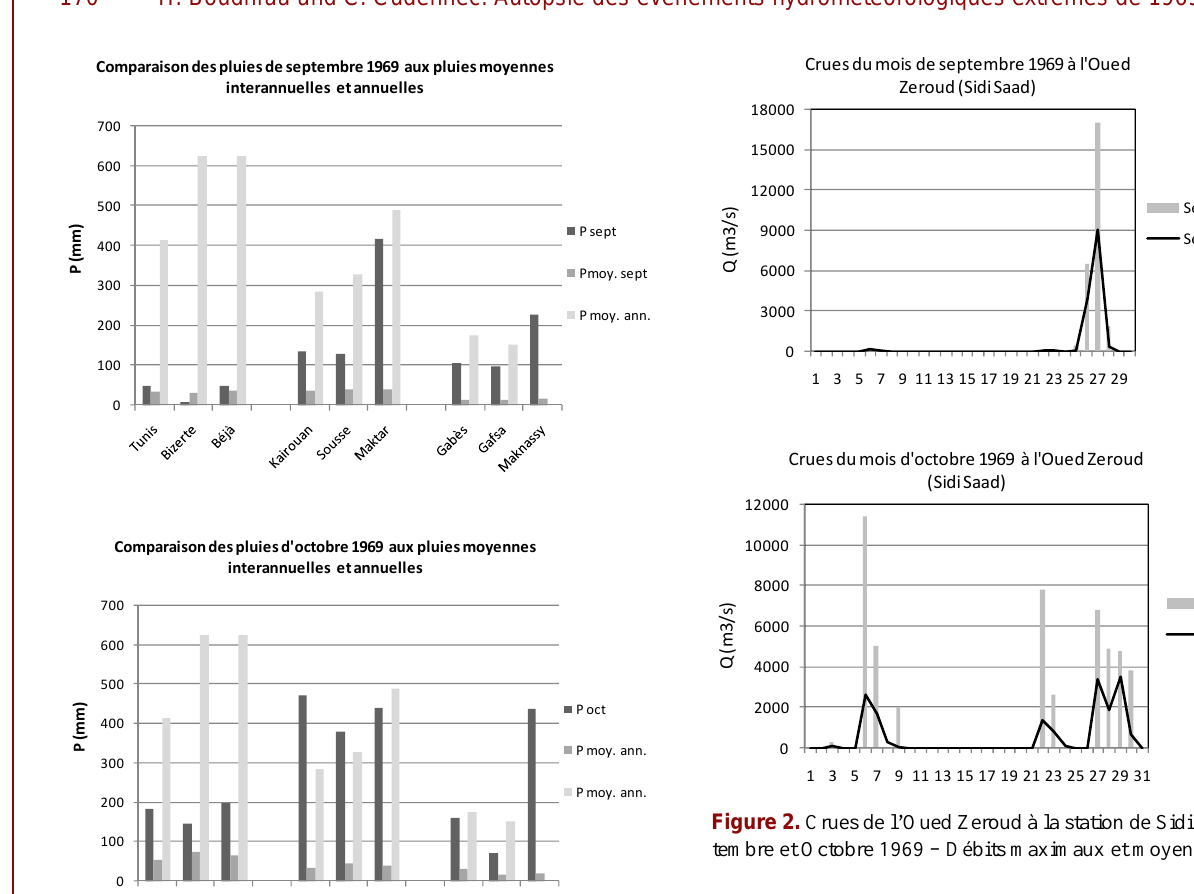
rentes régions de la Tunisie durant le mois d’Octobre